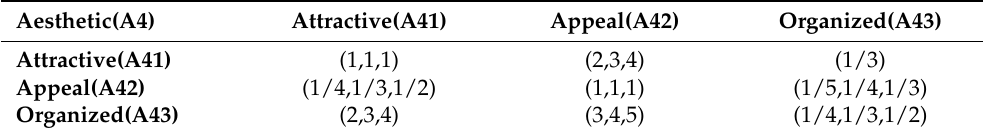
Table 8. Fuzzy-based comparison matrix associated with the sub-criteria in relation to the aesthetic (A4) criteria.